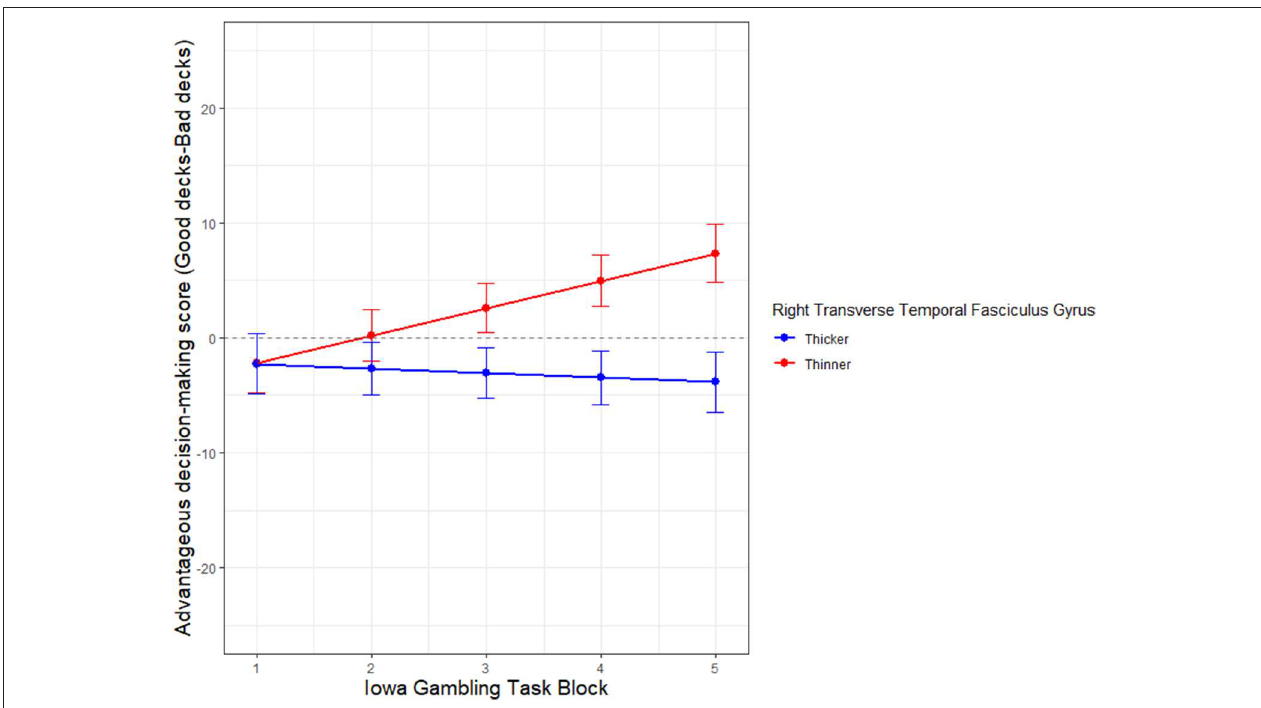
FIGURE 5 | Neural substrate that moderates decision-making performance in aging adults. The X axis represents Iowa Gambling Task (IGT) task performance in 5 blocks (1–5) of 20 trials each, from start to finish. Y axis represents IGT score. The cortical thickness of the neural substrate, right transverse tegmental gyrus (RTTFG), is median split into thick (blue) and thin (red). Control Variable: